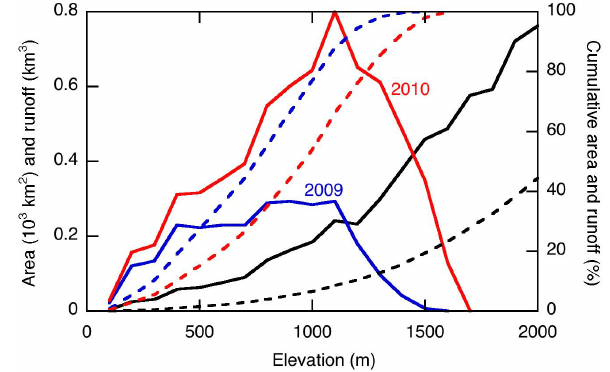
Fig. 7. Kangerlussuaq catchment surface area (black), and surface meltwater runoff for 2009 (blue) and 2010 (red) per elevation bin. Dashed lines illustrate cumulative